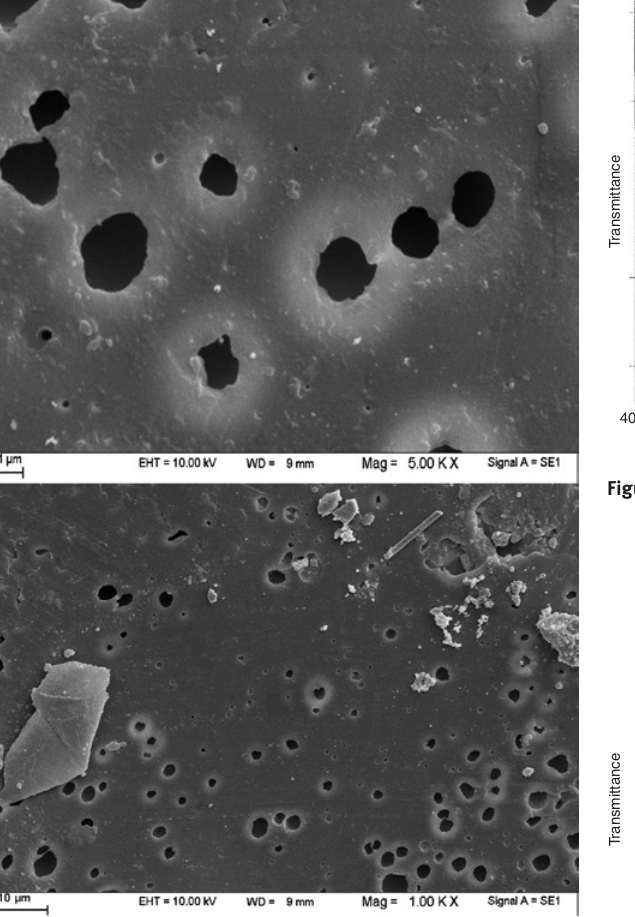
Figure 8: Surface SEM images of the nanocomposite.